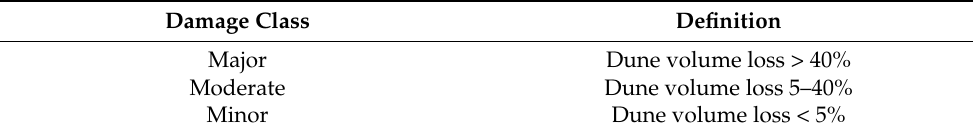
Table 6. Classification of storm-induced dune impacts based on quantitative